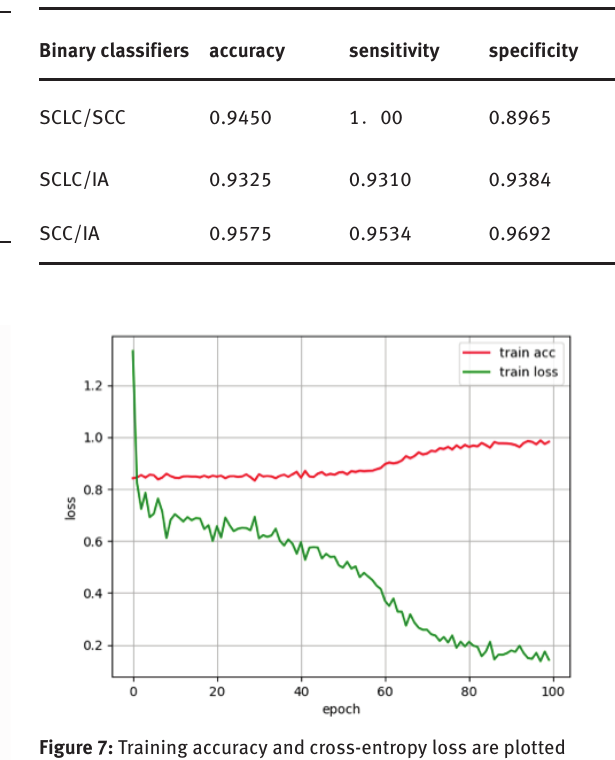
Table 4: Results of binary classifiers based our